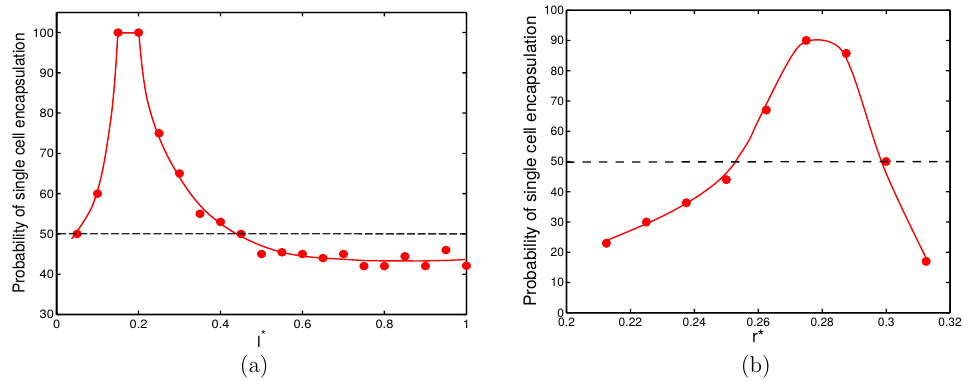
Figure 9. Probability of single cell encapsulation (%) for configurations at Ca i = Ca o = 10 − 3 with different non-dimensional ( a ) orifice length at fixed r ∗ = 0.25, d ∗ = 0.75 and ( b ) orifice radius at fixed l ∗ = 0.5, d ∗ =